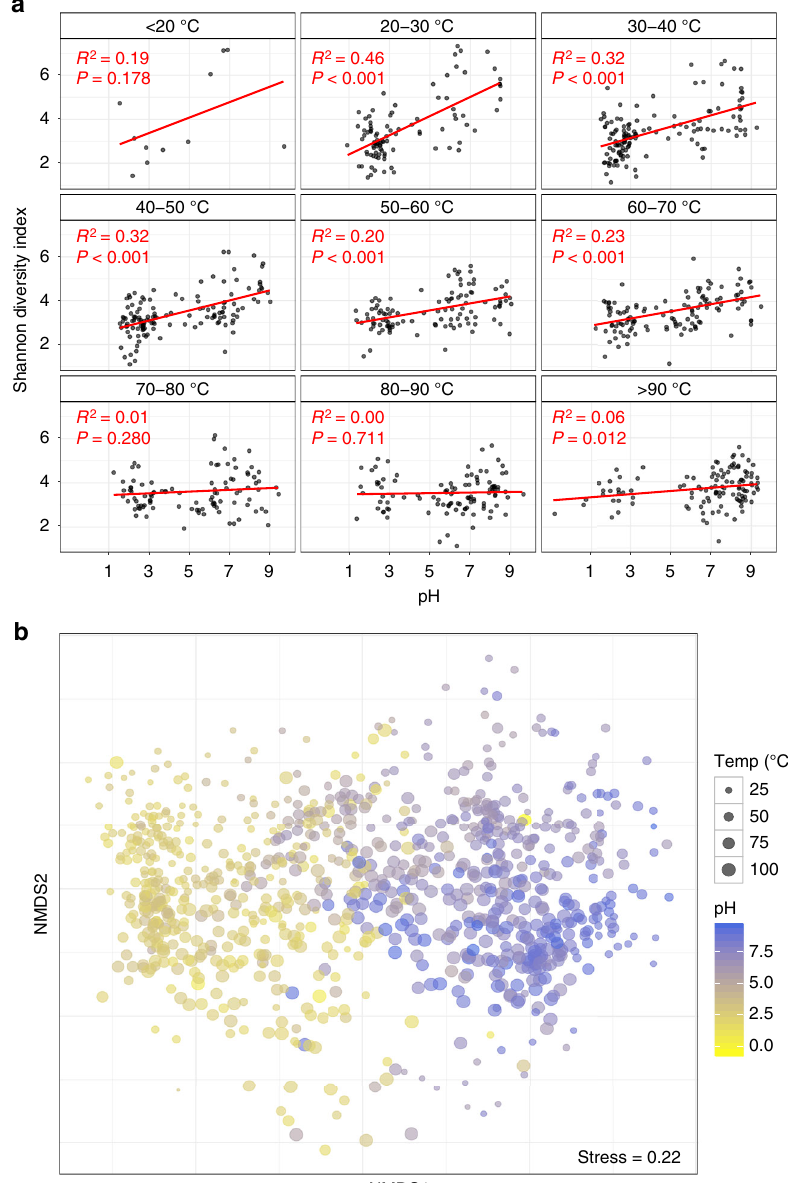
Fig. 2 Alpha and beta diversity as a function of pH and temperature. a pH against alpha diversity via Shannon index of all individual springs ( n = 925) in 10 °C increments, with linear regression applied to each increment. b Non-metric multidimensional scaling (NMDS) plot of beta diversity (via Bray – Curtis dissimilarities) between all individual microbial community structures sampled ( n =